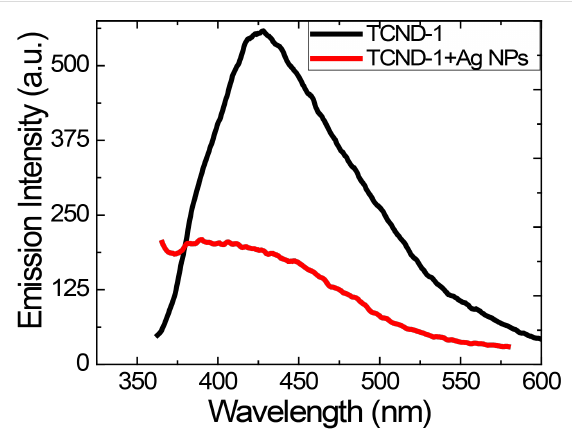
Figure 9: PL emission spectra of the aqueous TCND-1 solution and of the composite material solution, respectively, recorded at an excitation wavelength of 340